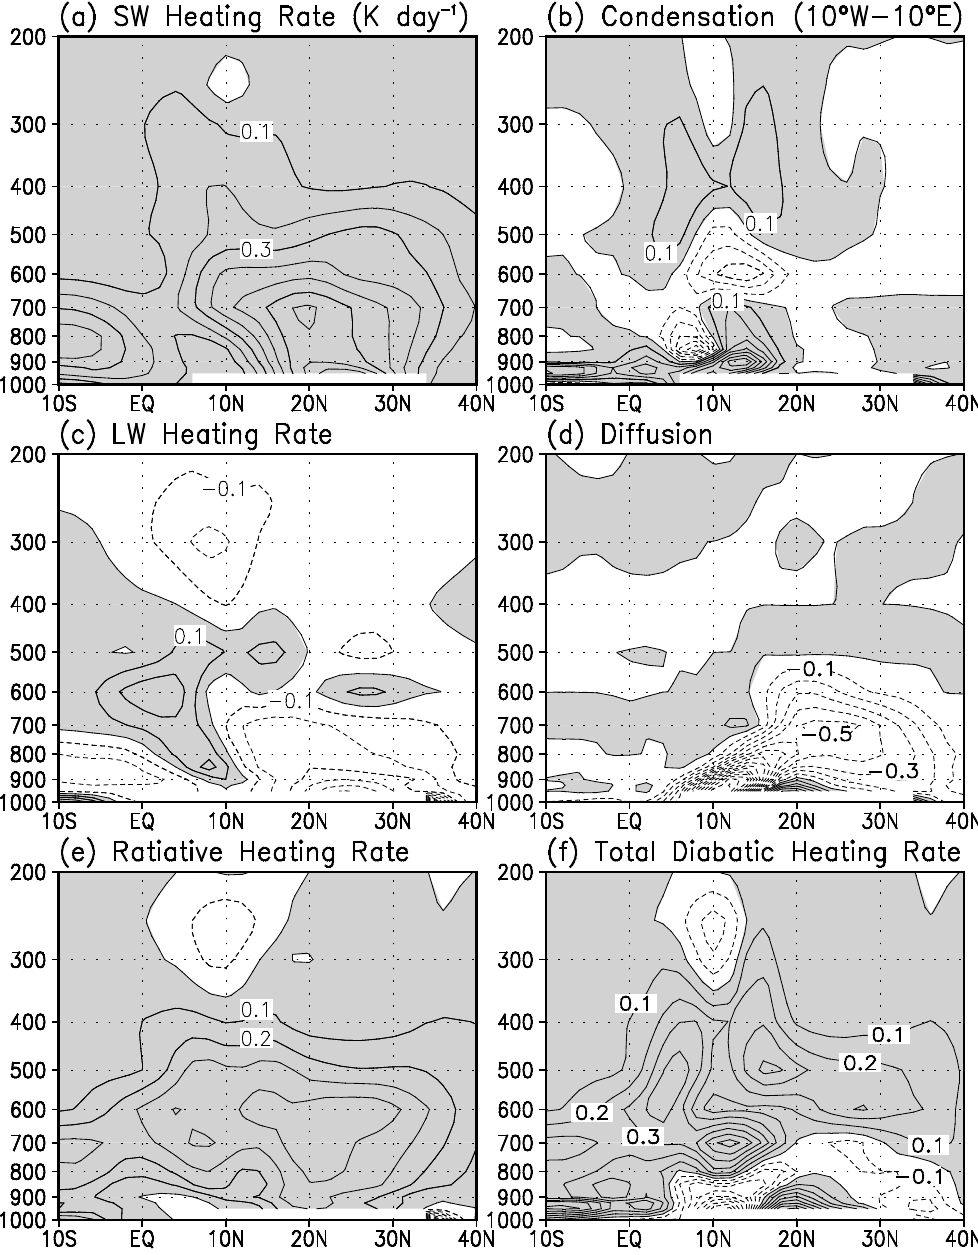
Fig. 8. Vertical meridional cross-section of heating rates for (a) shortwave, (b) longwave, (c) condensation, and (d) diffusion. Heating rate is in unit of ◦ C per Figure 8 Vertical meridional cross-section of heating rates for a) shortwave, b) longwave, c) condensation, , and d) diffusion. . Heating rate is in unit of o C per day.